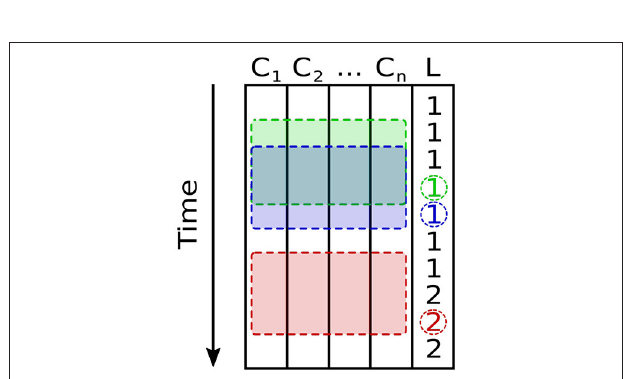
FIGURE 4 | Scheme used for sampling a multivariate time series with channels C 1 ... C n for the n 9 sensors, and label L . Two consecutive, = overlapping samples (time windows) and their corresponding labels are shown in green and blue, respectively. A third time window, shown in red, would be discarded because the measurements it contains span multiple